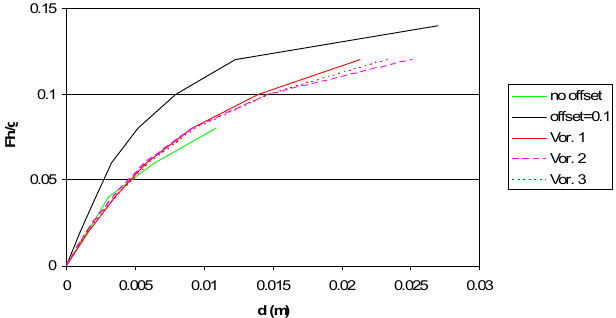
Figure 3. Failure load for wall models: regular model of square blocks with cross-joint offsets of 0 and 0.1 m, and three random Voronoi patterns.